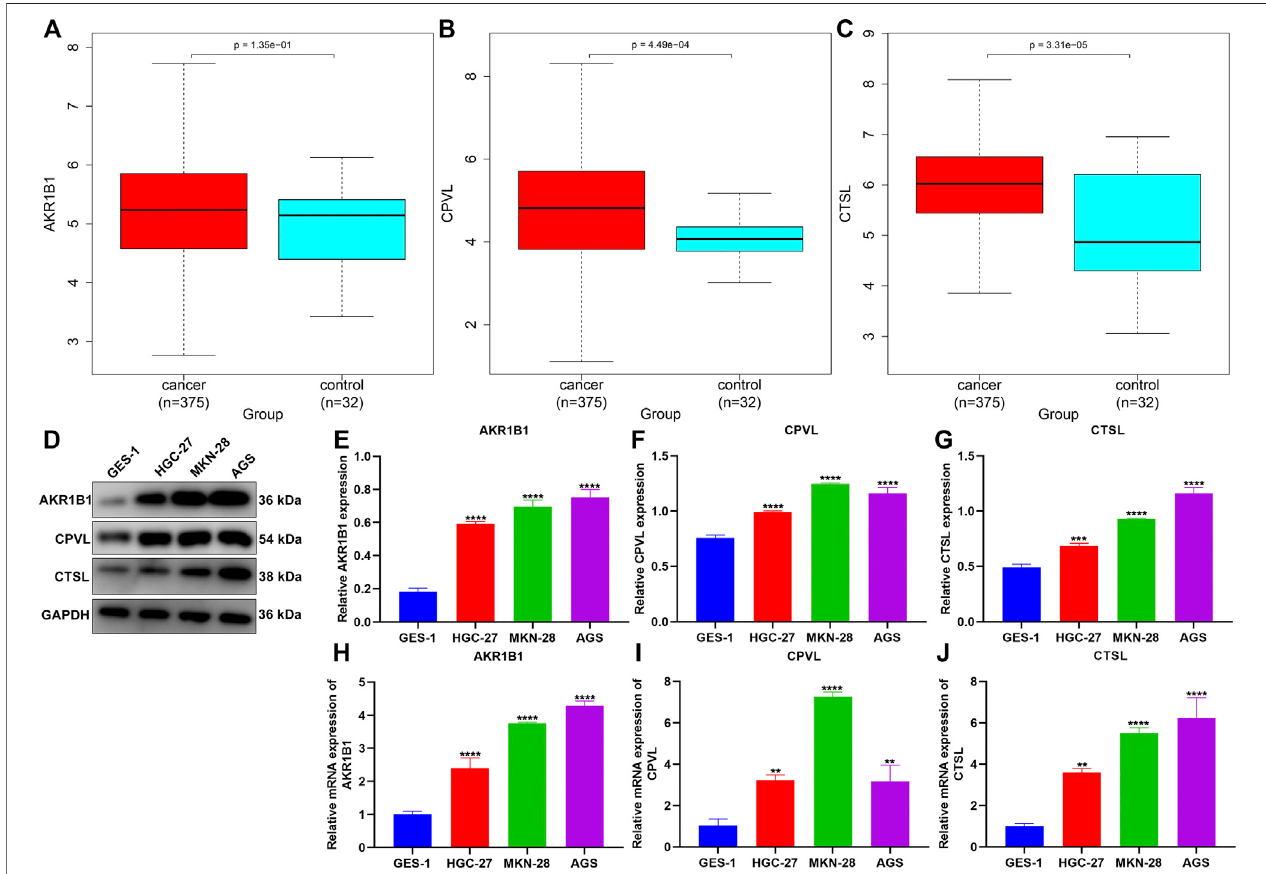
FIGURE9| Experimentalveri fi cationoftheexpression ofgenesintheTNF α -derivedgenesignature. (A – C) ComparisonoftheexpressionsofAKR1B1,CPVL,and CTSLbetweenGCandnormaltissues. (D – G) WesternblottingforvalidationoftheexpressionsofAKR1B1,CPVL,andCTSLinhumangastricmucosalcellsGES-1and humanGCcellsHGC-27,MKN-28,andAGS. (H – J) RT-qPCRforveri fi cationoftheexpressionsofAKR1B1,CPVL,andCTSLinhumangastricmucosalcellsGES-1and human GC cells HGC-27, MKN-28, and AGS. ** p < 0.01; *** p < 0.001; **** p <